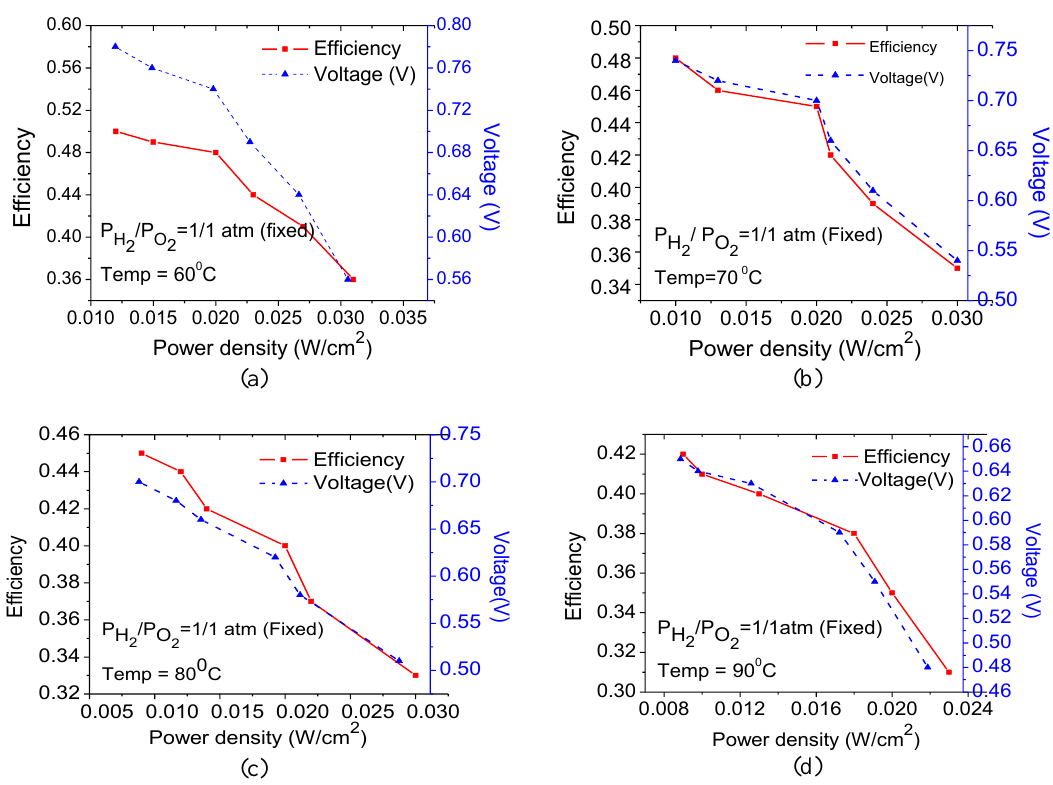
Figure 3. (a)-(d). Efficiency, power density and voltage at fixed reactants flow pressure and temperature